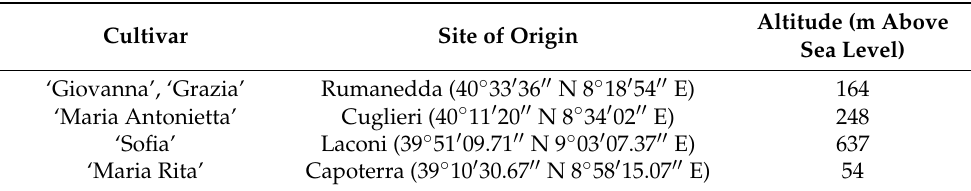
Table 1. Analysed five cultivars and its sites of origin. The altitudes and coordinate of the in sites of origin are reported.